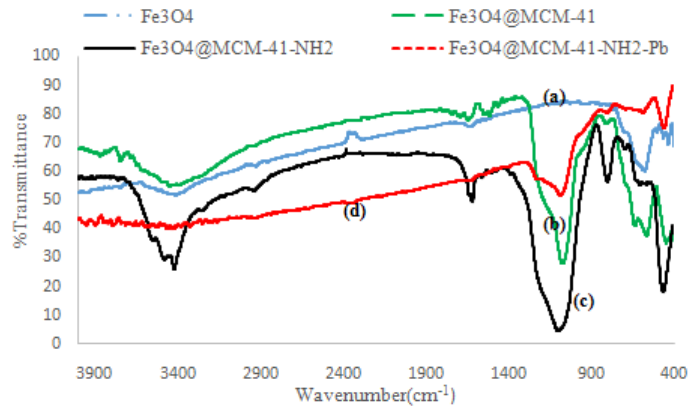
Fig. 1. FT-IR spectra of synthesis Fig. 1 FT-IR spectra of synthesis nanomagnetic.